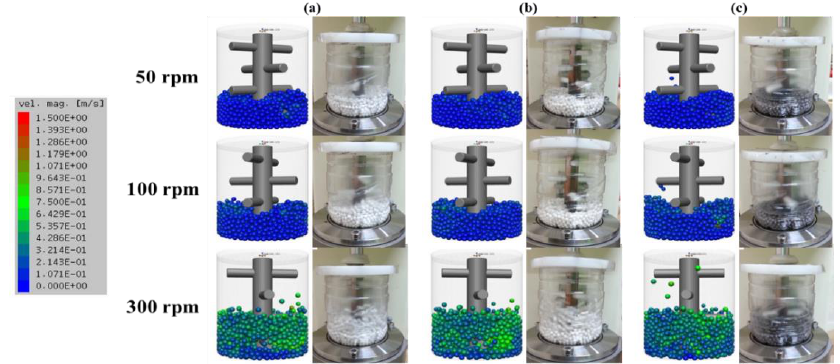
Figure 14. Simulation and actual snapshot photograph of the media motion by DEM simulation ( a )